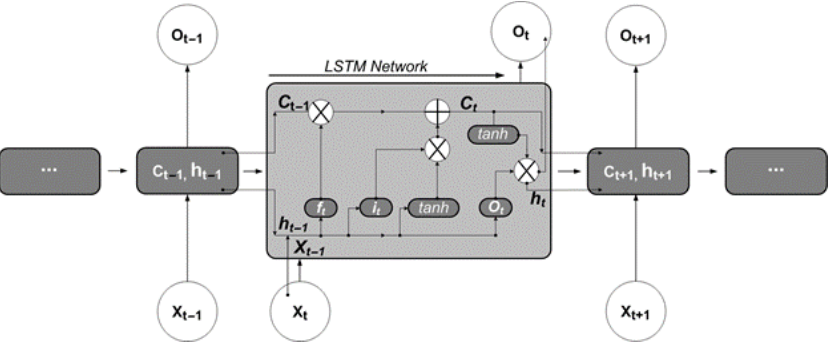
Figure 2. Conceptual diagram of LSTM model.